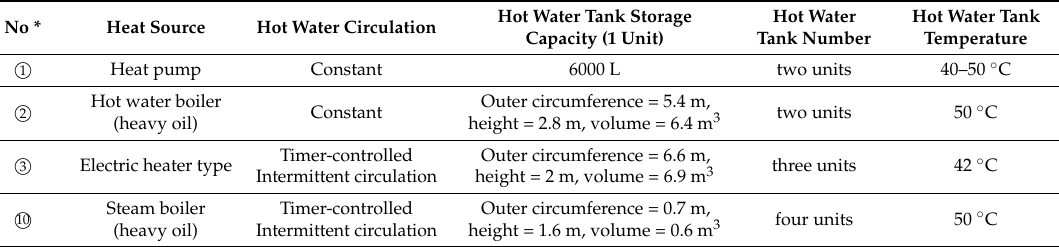
Table 4. Overview of hot water facilities investigated in Vietnamese hotels.